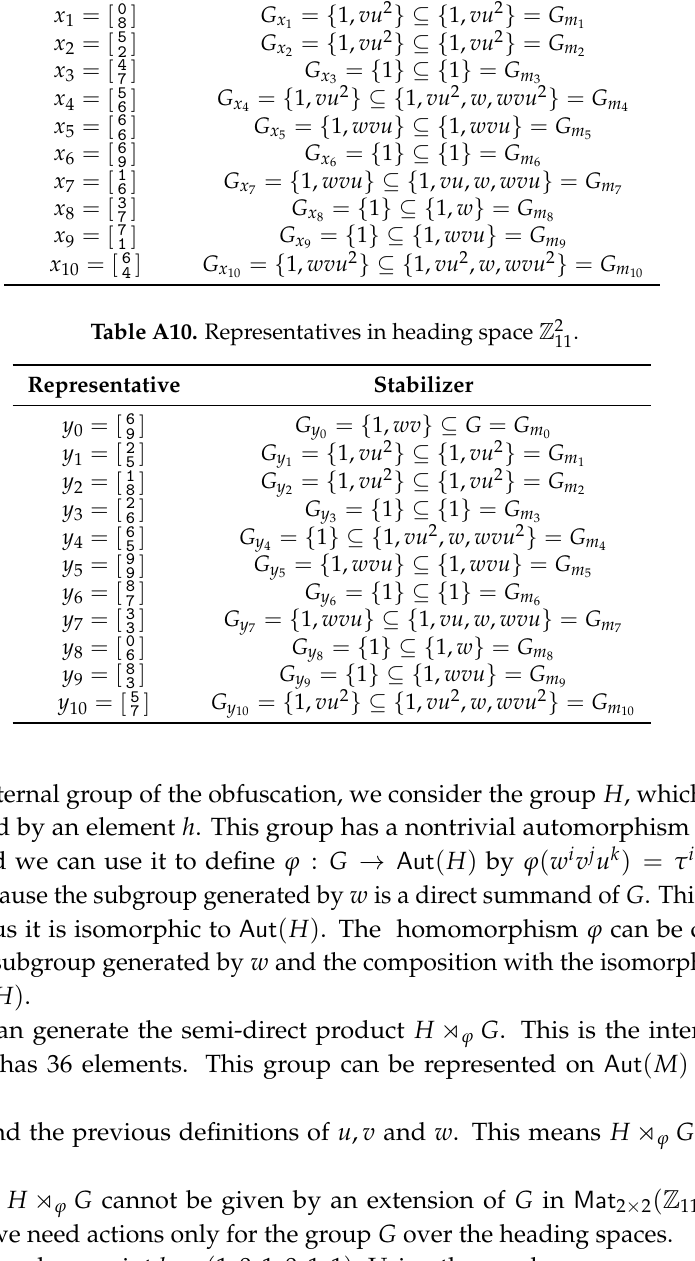
Table A9. Representatives in heading space Z 2